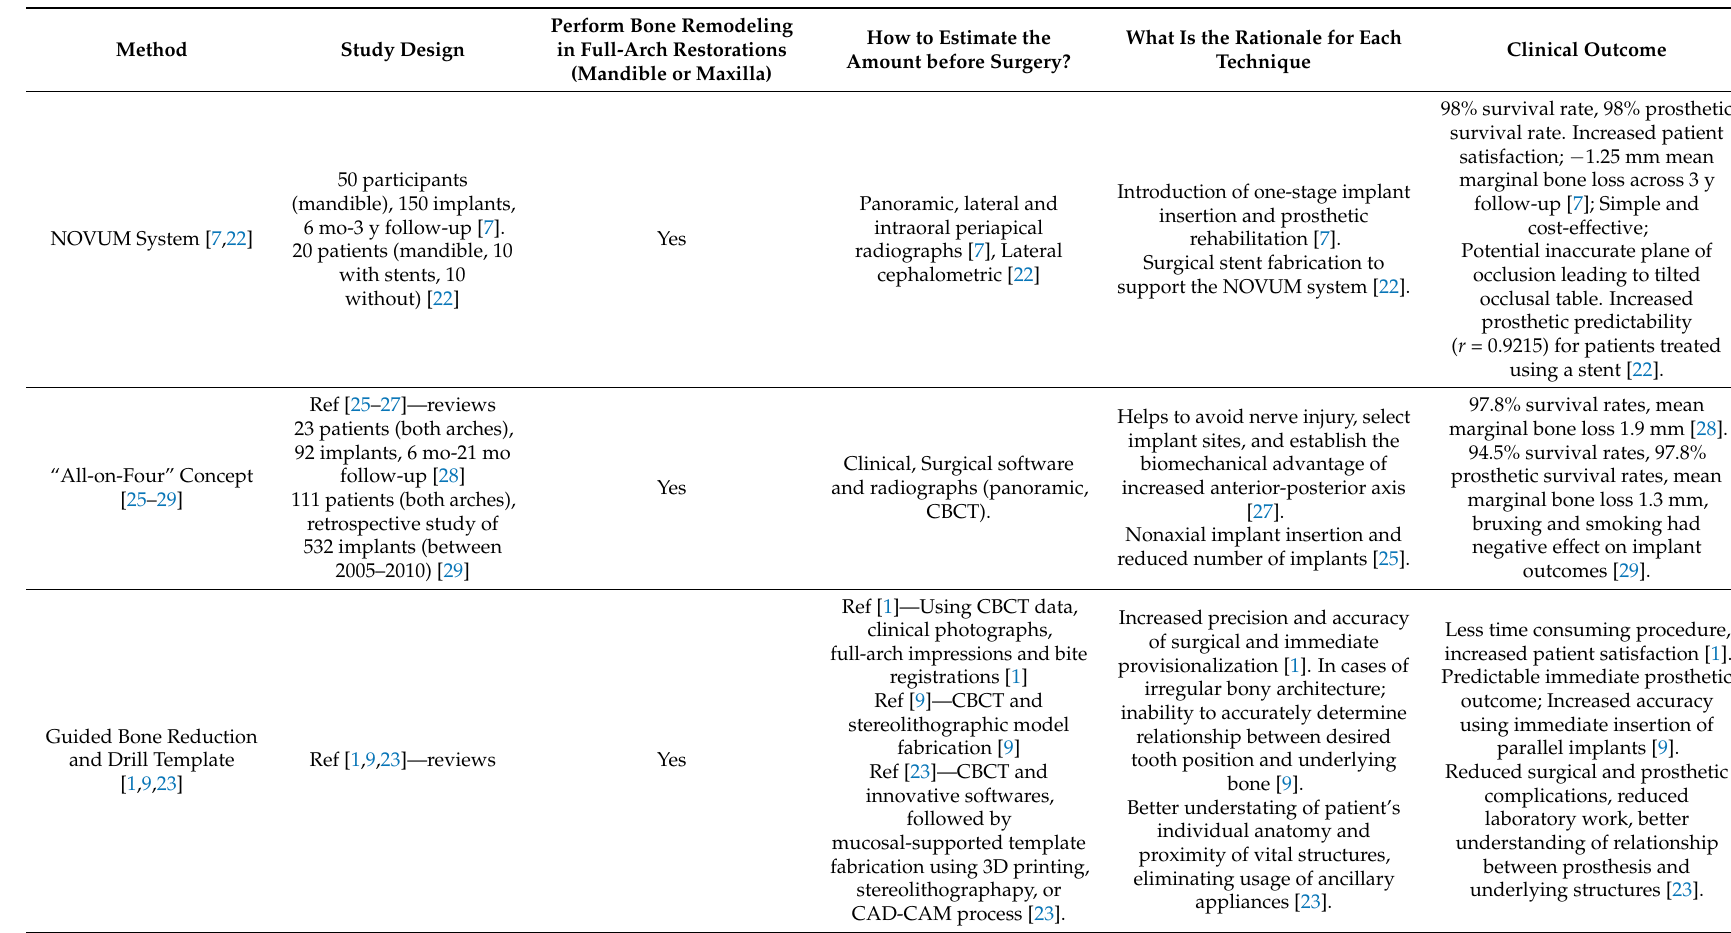
Table 1. Summary of included